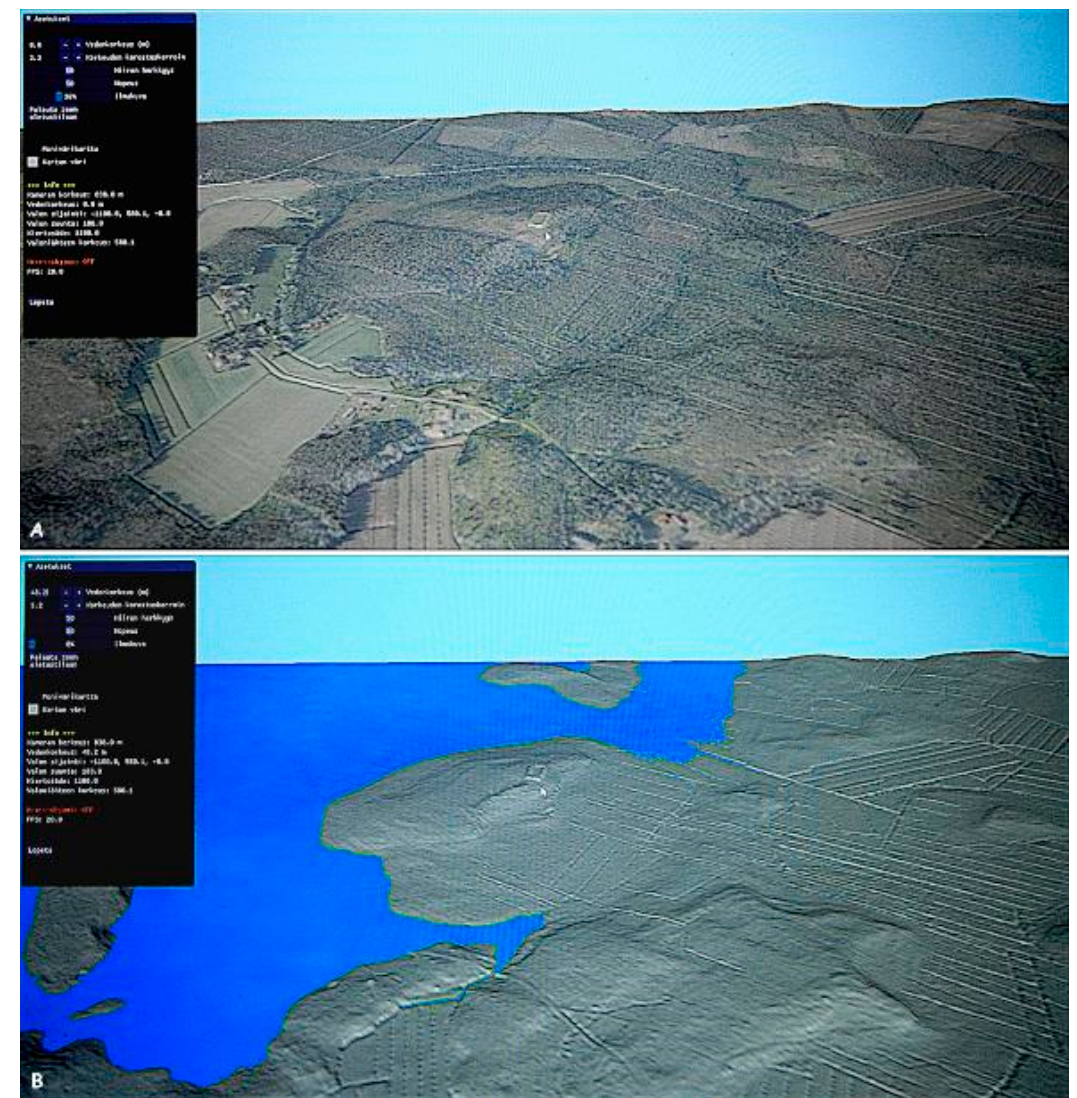
Figure 12. Screenshots of the Finnish metal-detecting hobbyists’ freeware program [142] for three dimension (3D) visualization of ALS data and aerial photographs. ( A ) Aerial photograph draped over an ALS DEM, with the Neolithic Kastelli “Giant’s Church” structure and housepits in the middle next to the cursor (see Figure 7); ( B ) Past water level reconstruction of the same scene (Illustration: Oula Seitsonen).